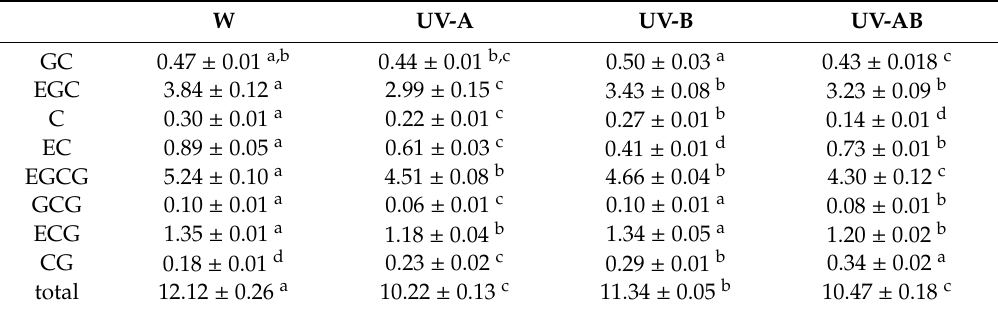
Table 3. Contents of catechins in each treatment (%, dry